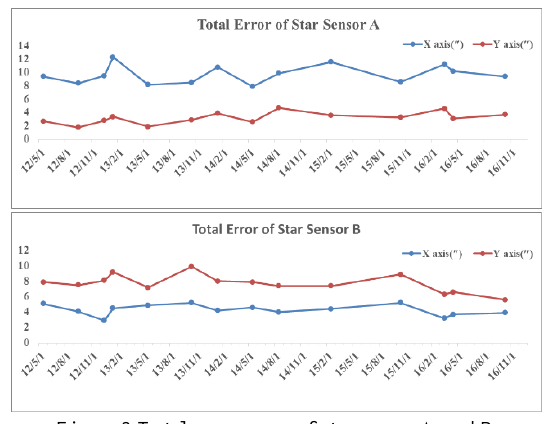
Figure 3 Total error curve of star sensor A and B 3.2 Error Statistics Based on the Ground Calibration Field Based on the ground calibration field, the curve of angles errors between the star sensor’s optical axis and the earth observation camera’s optical axis from May 20, 2012 to December 14, 2016 of the TH-1 02 satellite is shown in Figure 4.